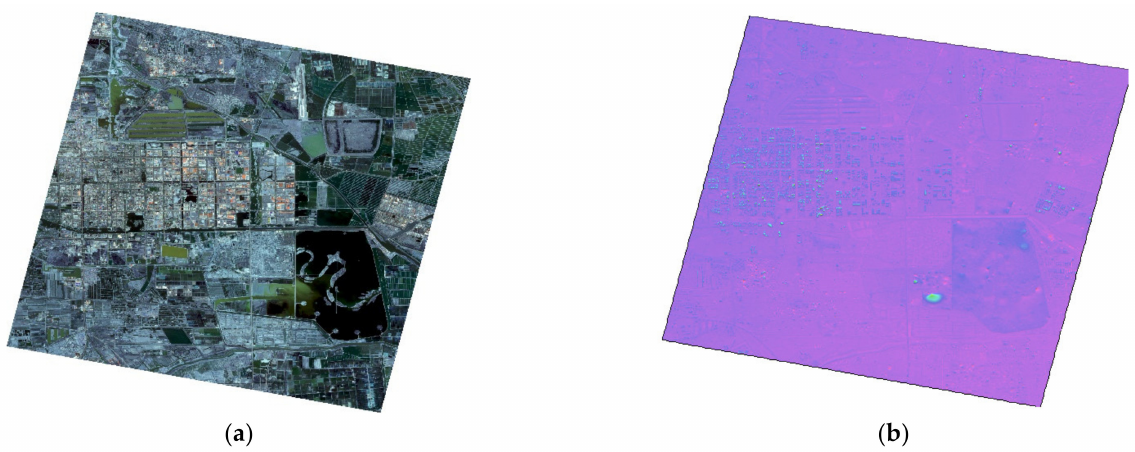
Figure 11. GF-7 fused multispectral image and DSM. ( a ) Fused multispectral image with a resolution of 0.8 m, ( b ) DSM with the resolution of 0.8 m derived from DLC